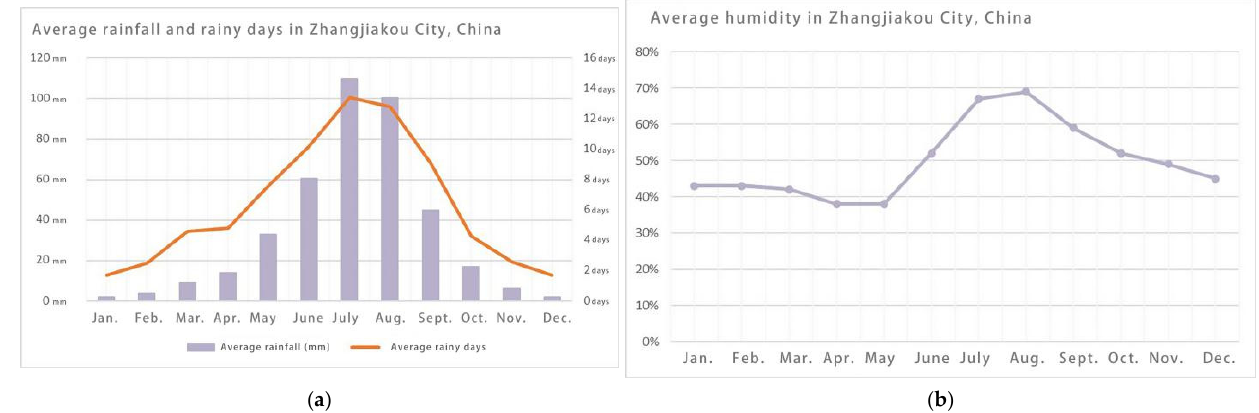
Figure 4. Average rainfall, rainy days and humidity in Zhangjiakou City, China. ( a ) Average rainfall and rainy days in Zhangjiakou City, China; ( b ) average humidity in Zhangjiakou City, China. (3) Sunshine Zhangjiakou City receives an average of more than 9 sun-hours per day and reaches more than 12 sun-hours in 7 months of a year. The annual solar radiation in Zhangjiakou City is considered very high by importing the meteorological data of Zhangjiakou City able energy sources in power generation and heating.